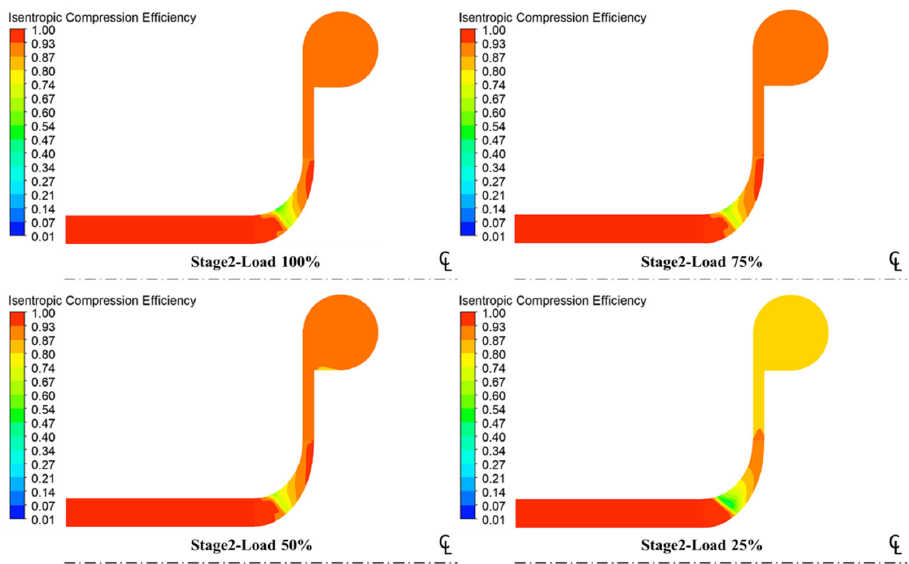
Figure 19. Meridional contour maps of the second stage compression isentropic efficiency with R-513A refrigerant under various loads.